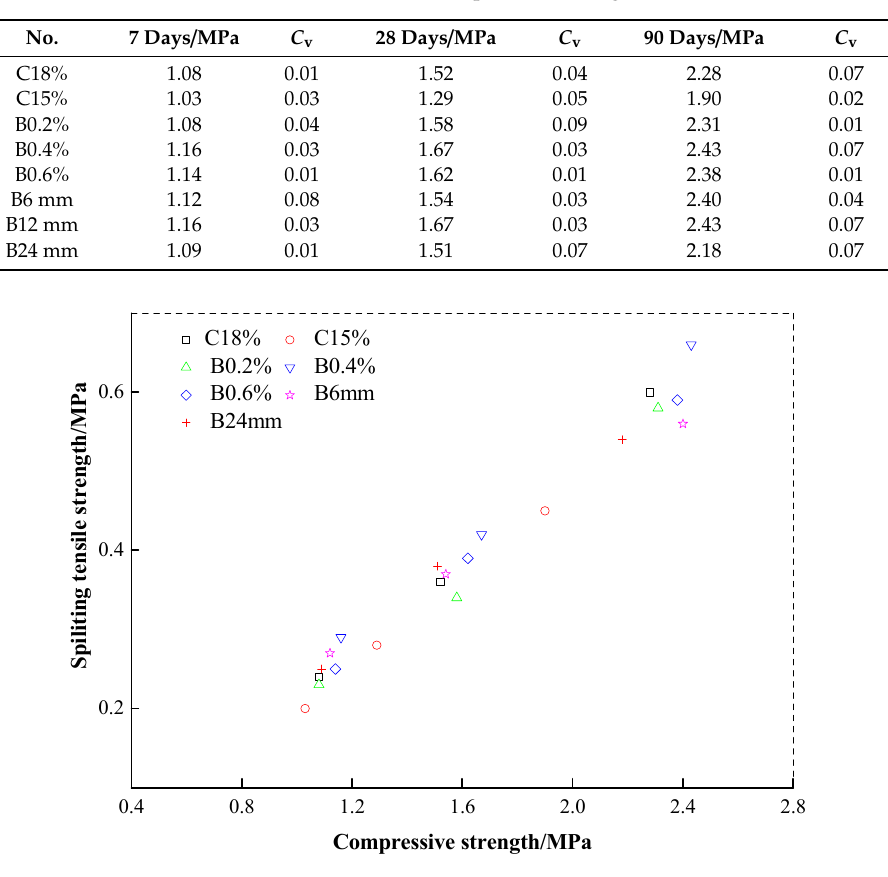
Figure 9. The relationship between compressive strength and tensile strength.